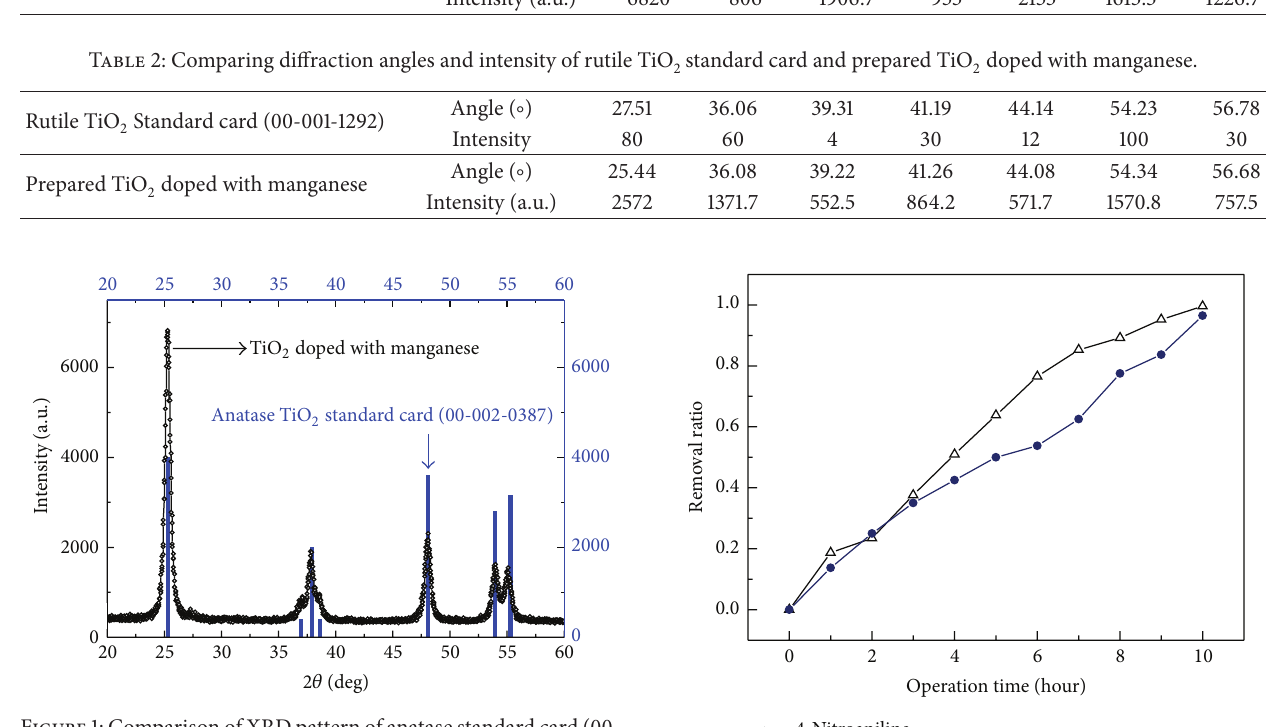
Figure 1: Comparison of XRD pattern of anatase standard card (00- 002-0387) and TiO 2 doped with manganese oxalate.